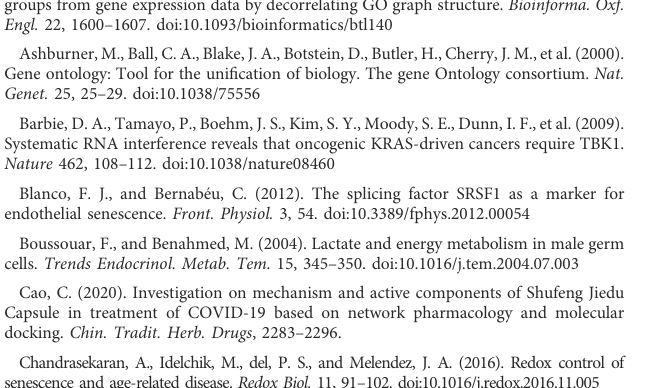
SUPPLEMENTARY FIGURE S2 After WIKIPATHWAYS enrichment of genes signi fi cantly decreased in patients with COVID-19 infection, the fi rst 10 pathways with the most signi fi cant p value were obtained. SUPPLEMENTARY TABLE S1 Genes contained in related pathways (GOBP_CELLULAR_SENESCENCE, KEGG_SENESCENCE, KEGG Coronavirus_disease